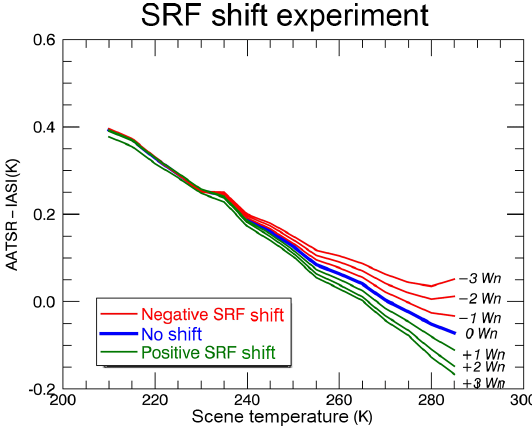
Figure 4. Temperature-dependent bias of the AATSR-IASI-A for the 12µ channel.